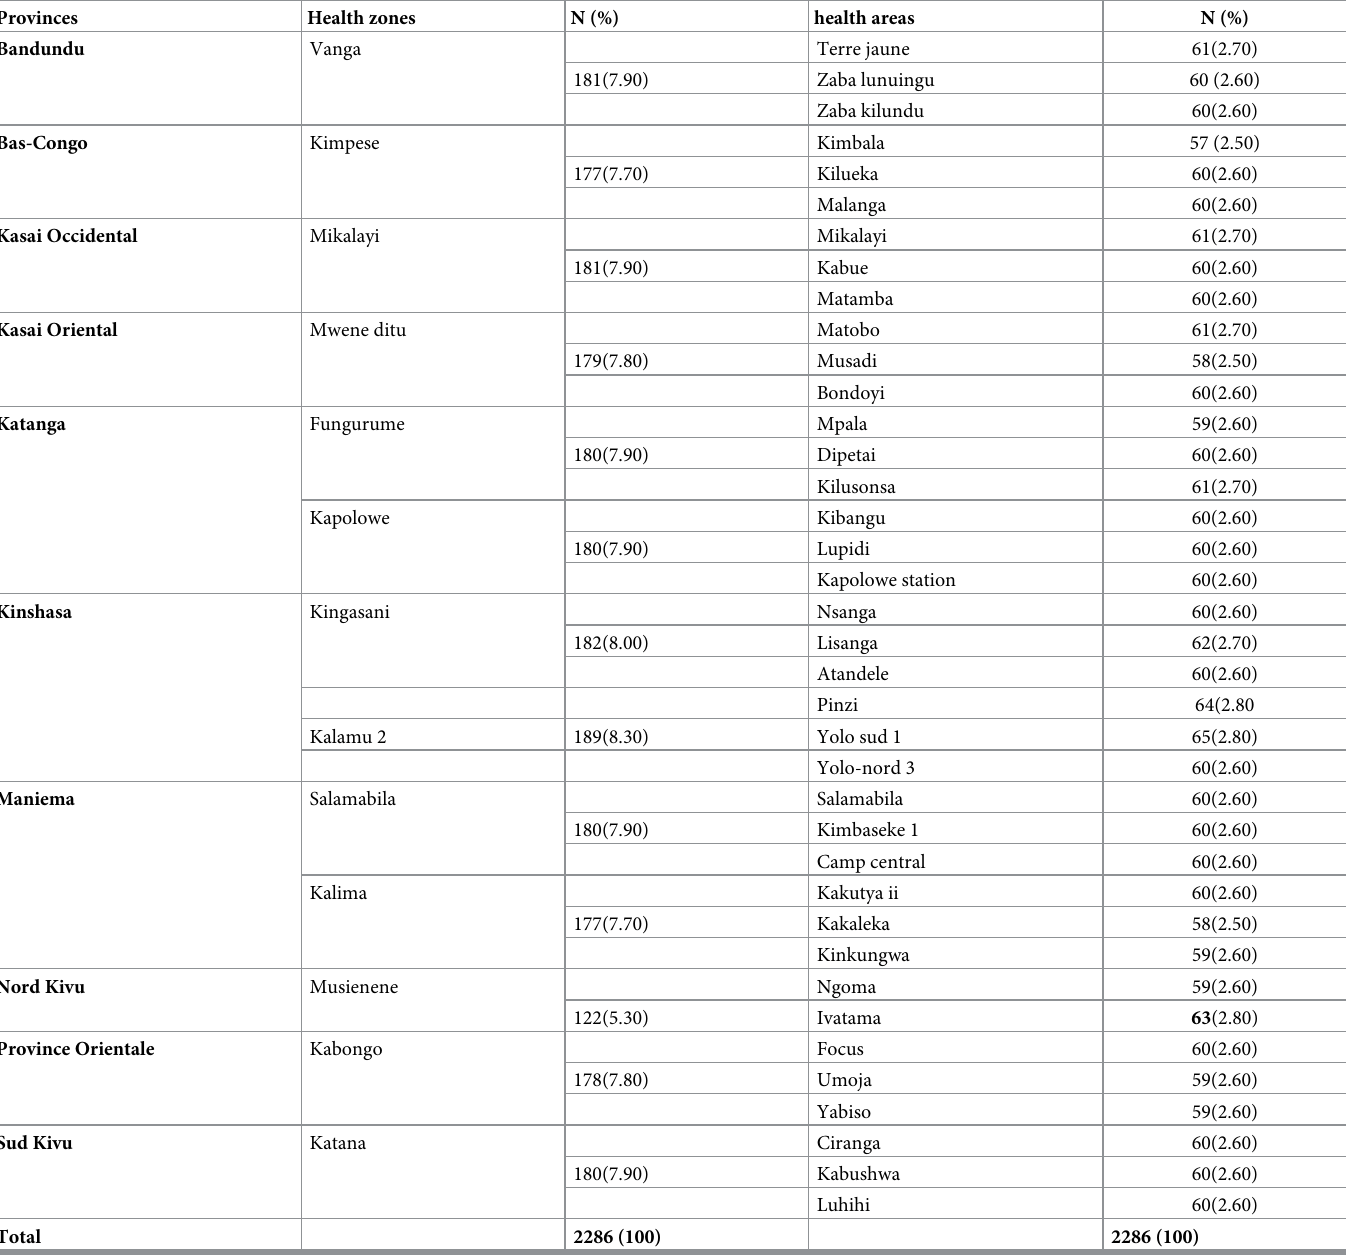
Table 1. Distribution of respondents by health zones and health areas.